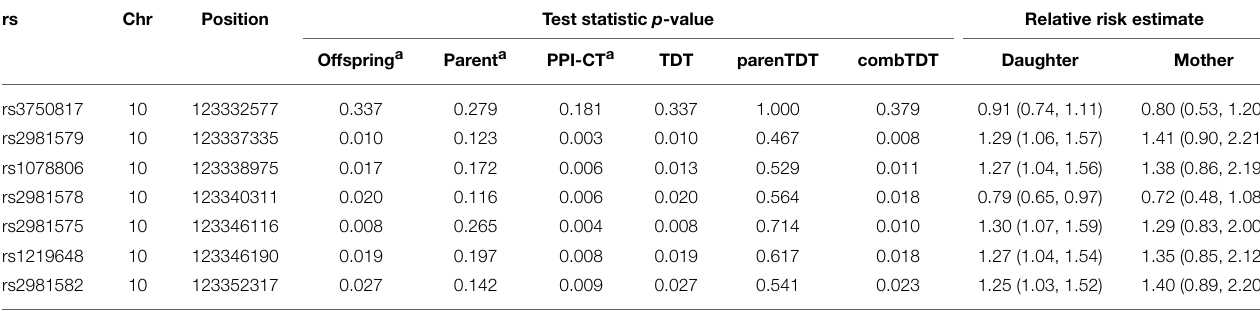
TABLE 2 | Results from various tests applied to the breast cancer FGFR2 example. rs Chr Position Test statistic p -value Relative risk estimate Offspring a Parent